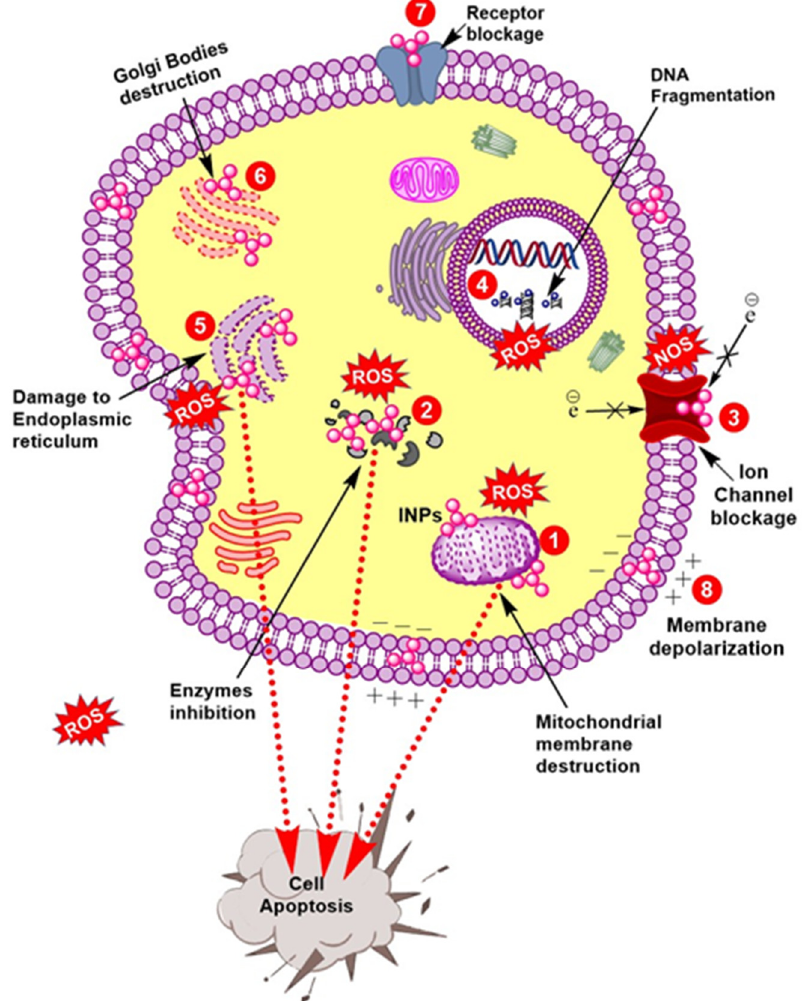
Figure 2. Anticancer potential of microbes mediated Nanoparticles. (1), (2), (5), and (6) Iron nanoparticles interfere with organelles and enzymes functioning, particularly in mitochondria, endoplasmic reticulum, and Golgi bodies via reactive oxygen species (ROS) production and induces apoptosis. (3) Ion channel blockage leads to death of cancerous cells. (4) INPs kills cancerous cells by breaking nucleic acids, particularly in DNA. (8) Membrane polarity is disturbed.